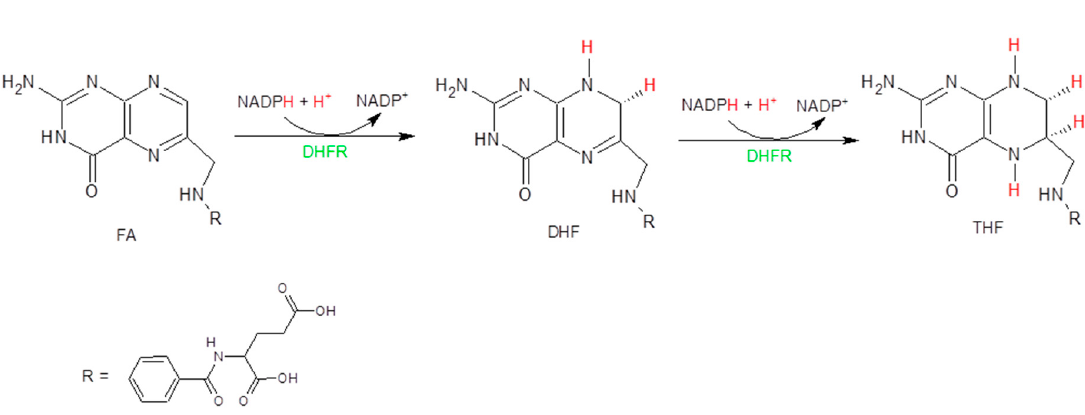
Figure 1. Reduction of FA in THF.